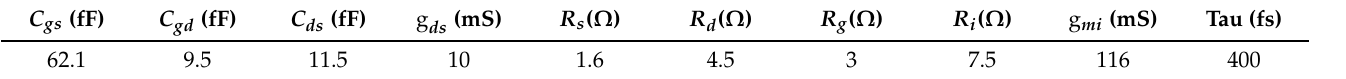
Table 1. The parameters of the small-signal equivalent circuit of devices.